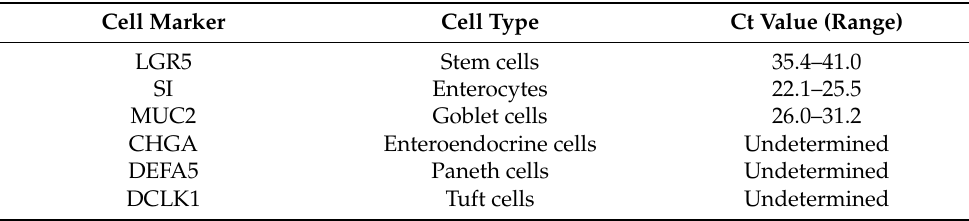
Table 3. Relative gene expression level of intestinal epithelial cell markers in differentiated HIE 2D monolayers using cycle threshold (Ct) value of RT-PCR assay as a proxy. Cell Marker Cell Type Ct Value